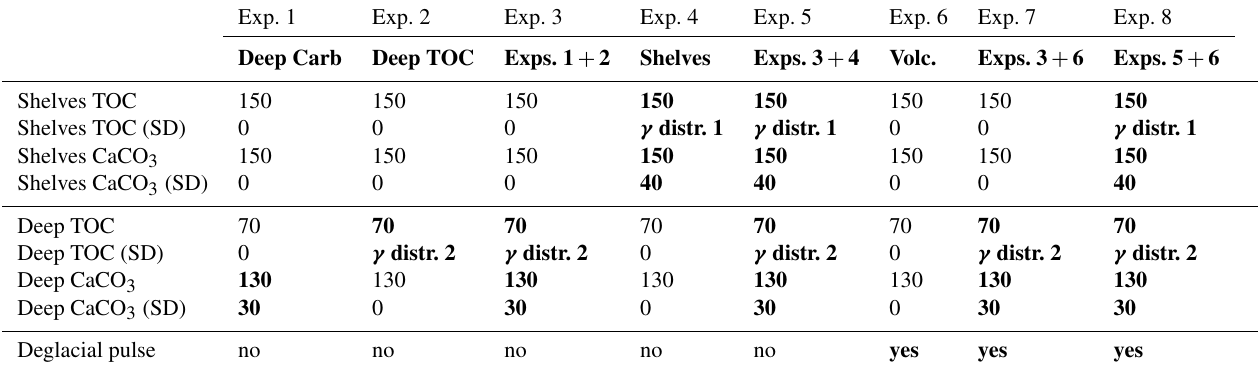
Table 3. Modern burial distribution (PgCkyr − 1 ) used for the Monte Carlo simulations (mean and standard deviation). When the distribution type is not specified, a normal distribution was used. Boldface indicates variable fluxes over time. Results of experiments 1 and 2, 3 to 5, and 6 to 8, are shown in Figs. 7, 8, and 10, respectively. The gamma distributions ( γ distribution) used for C org burial are shown in Fig.